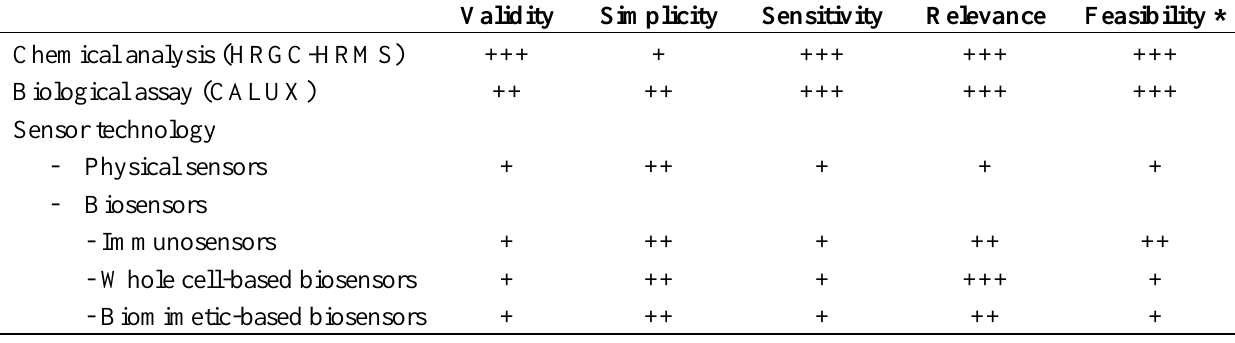
Table 3. Assessment of different determination methods for detection of dioxin and DL-PCB contamination along the food